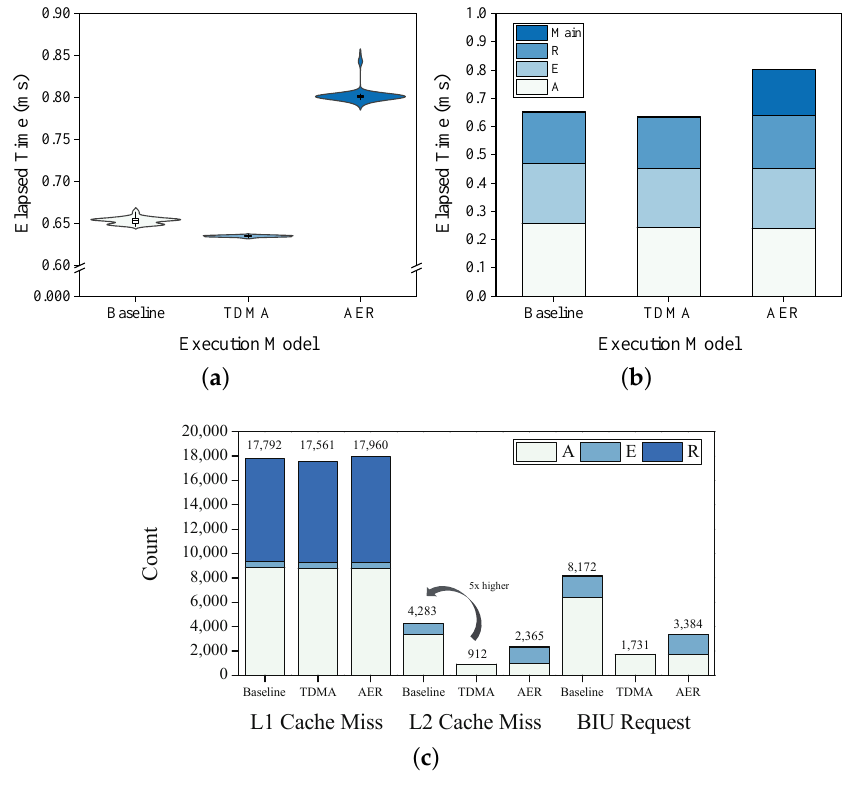
Figure 15. Benchmark measurement results by the execution model. ( a ) Execution time. ( b ) Execution time by each phase. ( c ) Cache misses and BIU